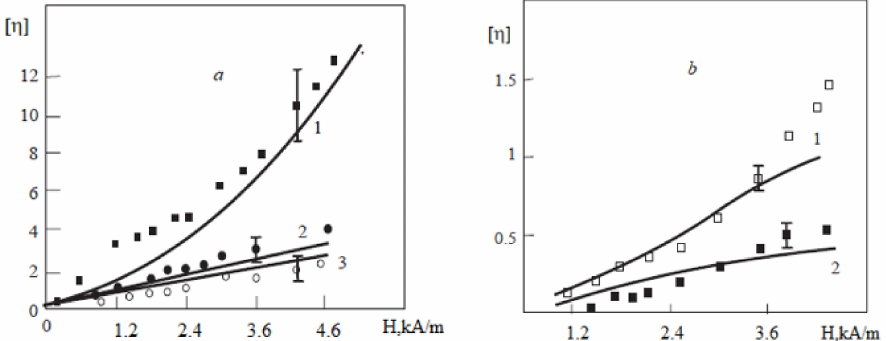
Figure 8. The dependence of the reduced magnetic e ff ective viscosity on magnetic field H inside the ferrofluid [68]. The diameter of the magnetic core of the “large” particles was d l = 16.5 nm, while their hydrodynamic volume concentration was ϕ l = 0.017. The dots are experimental data, while the . γ = . γ = lines correspond to calculations: ( a ) 0.1 s − 1 (1), 0.5 s − 1 (2), and 0.9 s − 1 (3); ( b ) 1.05 s − 1 (1) and 5.23 s − 1